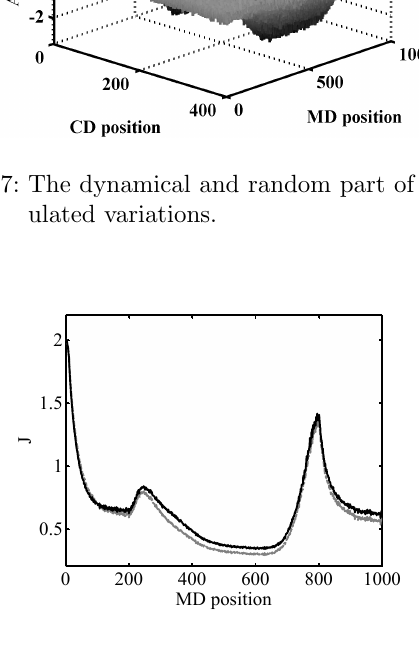
Figure 8: Control performance against dynamical dis- turbances with (solid line) and without (dot- ted gray line) the automated tuning.